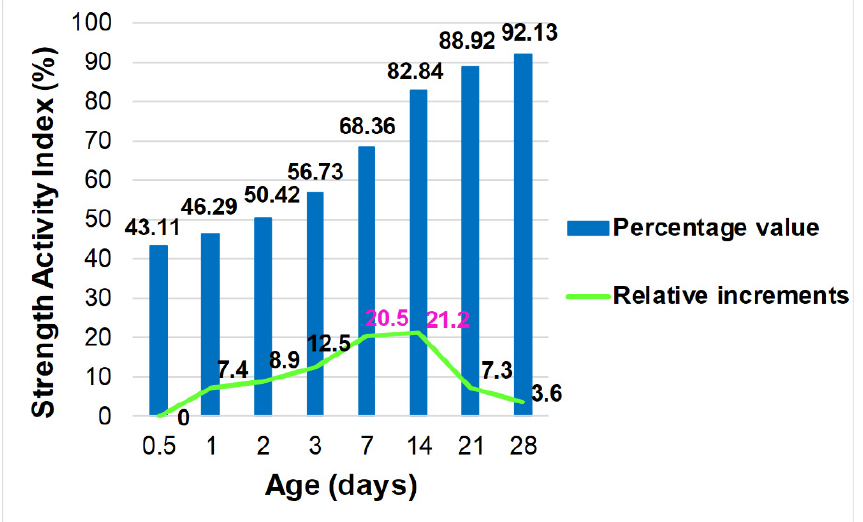
Figure 3. Changes in pozzolanic activity of fly ash used.